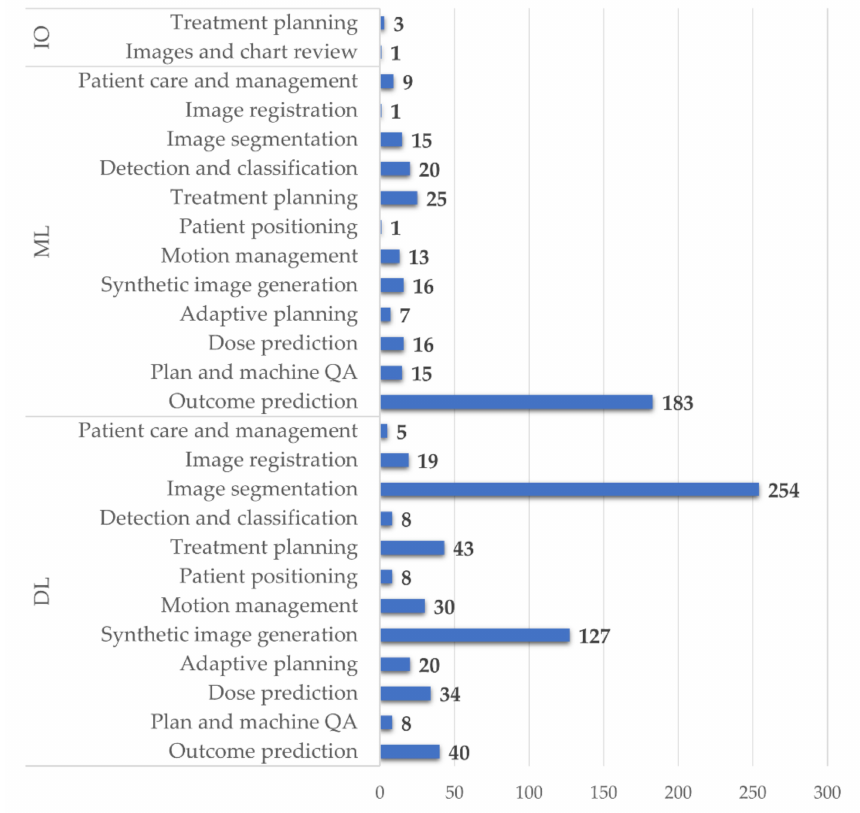
Figure 4. The numbers of identified papers according to the AI subgroups (IO, ML, and DL) and RT workflow steps (highlighted in Figure